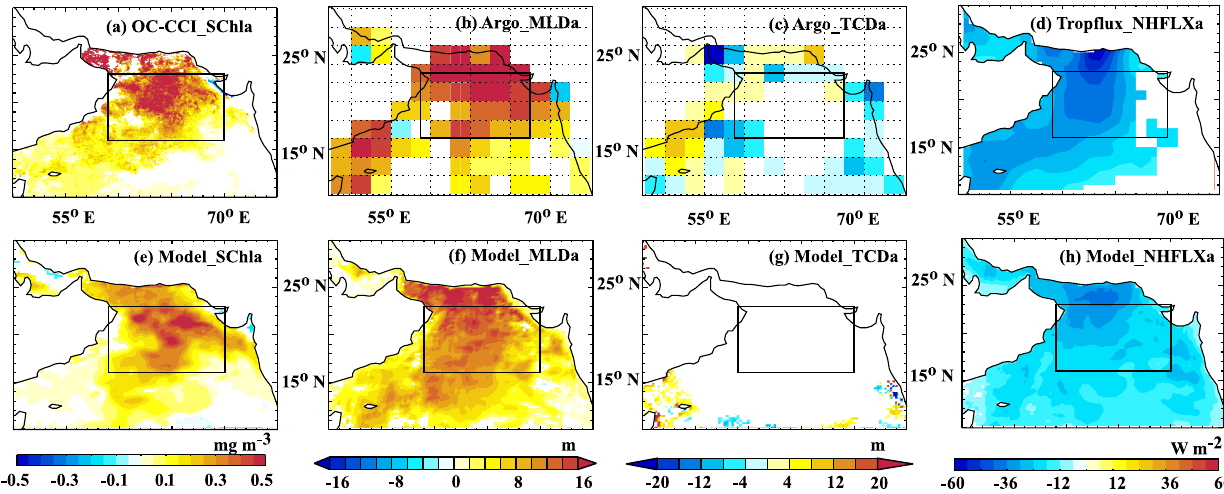
Figure 10. Observed interannual anomalies of (a) SChl (OC-CCI), (b) MLD, (c) TCD (Argo-derived), and (d) net surface heat flux (TropFlux) for composite SChl blooms (built from half of the difference between positive and negative events highlighted in Fig. 8). The SChl composites are built from the months of max SChl anomaly: March 2003, March 2008, and March 2012 for positive events; March 2007, March 2009, and February 2013 for negative events. The MLD and TCD composites are built from the months of February of the same year. (e–h) Idem for the model. For the model, composites are built from the positive and negative events highlighted in Fig. 7 (SChl is composited using March 1995, 2000, 2008, and 2012 and February 2001 for positive events and March 1999, 2004, 2006, 2007, and 2009 for negative events; MLD and TCD are composited using February of the same years). Regions where composite values are less than the standard error are displayed in